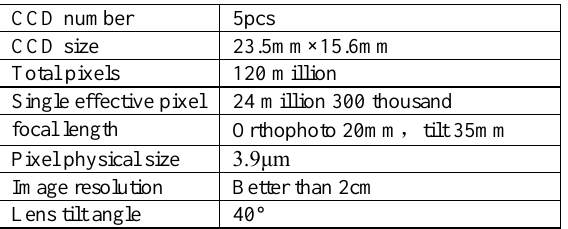
Table1. Main parameters of Lingjing A5 aerial camera